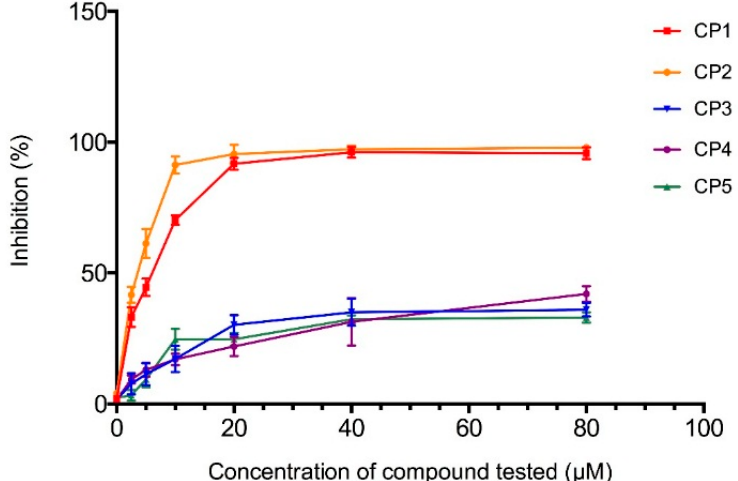
Figure 9. Inhibition (%) of each one of the five compounds (1 β ,10 β -epoxydesacetoxymatricarin (CP1), leucodin (CP2), 5-demethylsinensetin (CP3), 2-(3,4-dimethoxy-phenyl)-3-hydroxy-5,6,7-trimethoxy- chromen-4-one (CP4) and salvigenin (CP5)) plotted against the tested concentrations (0, 2.5, 5, 10, 20, 40, 80 µ